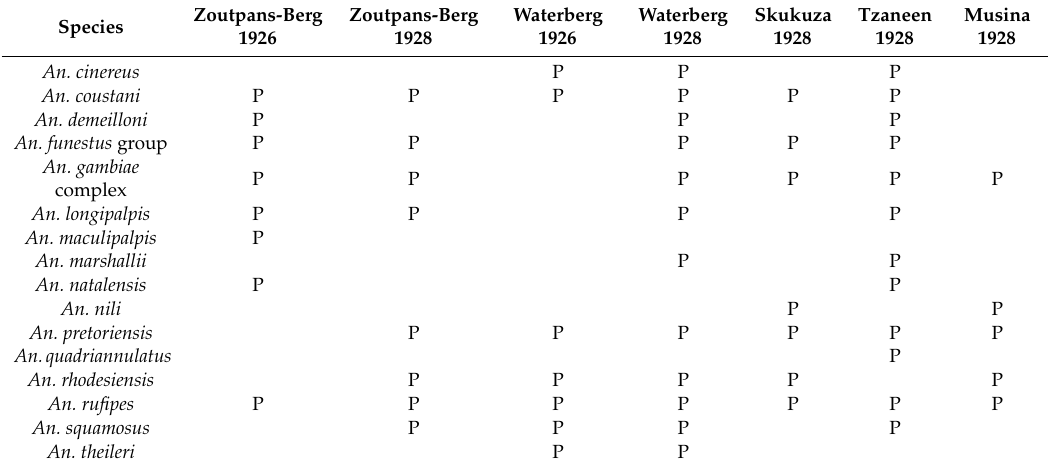
Table 2. Survey of anopheline mosquitoes from the malaria endemic regions in the northern (Limpopo Province) and north-eastern (Mpumalanga Province) “Transvaal” [6,7]. P = present.